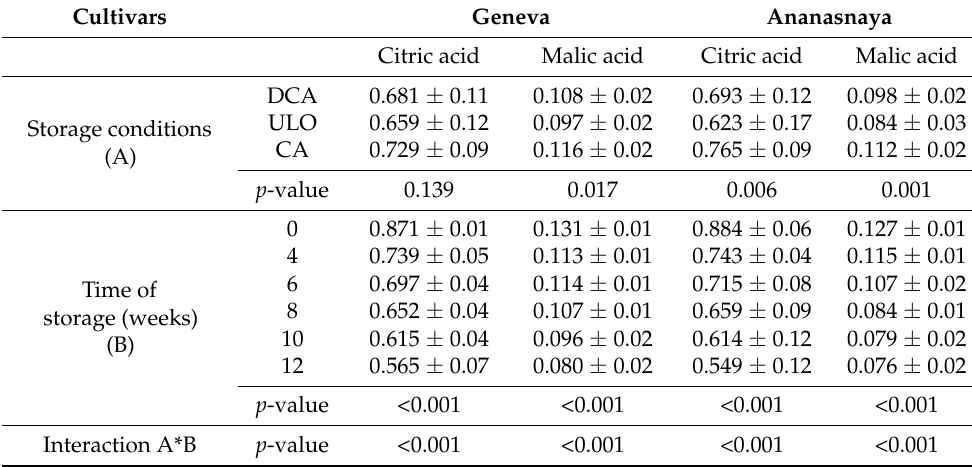
Table 7. Changes in citric acid and malic acid contents (g · 100 g − 1 F.W.) measured in ‘Geneva’ and ‘Ananasnaya’ minikiwi fruit in the postharvest period in 2018.